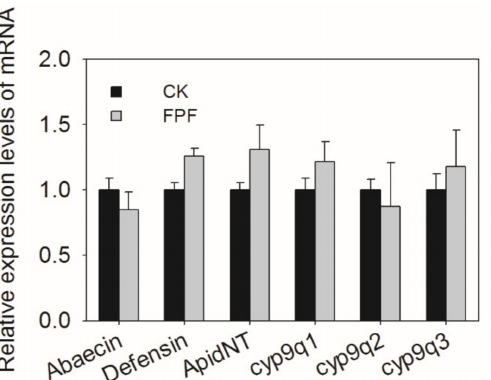
Figure 3. Effects of FPF on the relative expression levels of on the immune genes (Abaecin, Defensin, and ApidNT), detoxification genes (CYP9Q1, CYP9Q2, and CYP9Q3) in A. mellifera larvae. After exposed to 4 ppm FPF for five days, larvae were collected and total RNA was extracted. Each sample was assayed three times. Expression levels were normalized to Actin and then to the gene expression level of the CK. Values represent mean ± SEM ( n = 4). Significant differences between FPF treatment and CK were analyzed by one-way